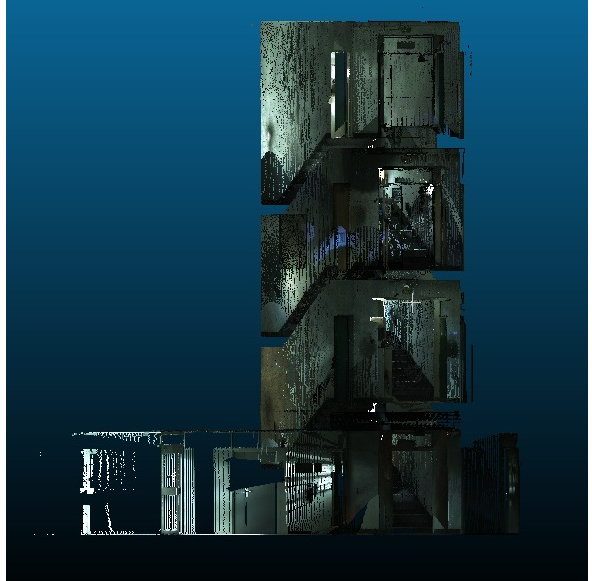
Figure 2: TLS point cloud